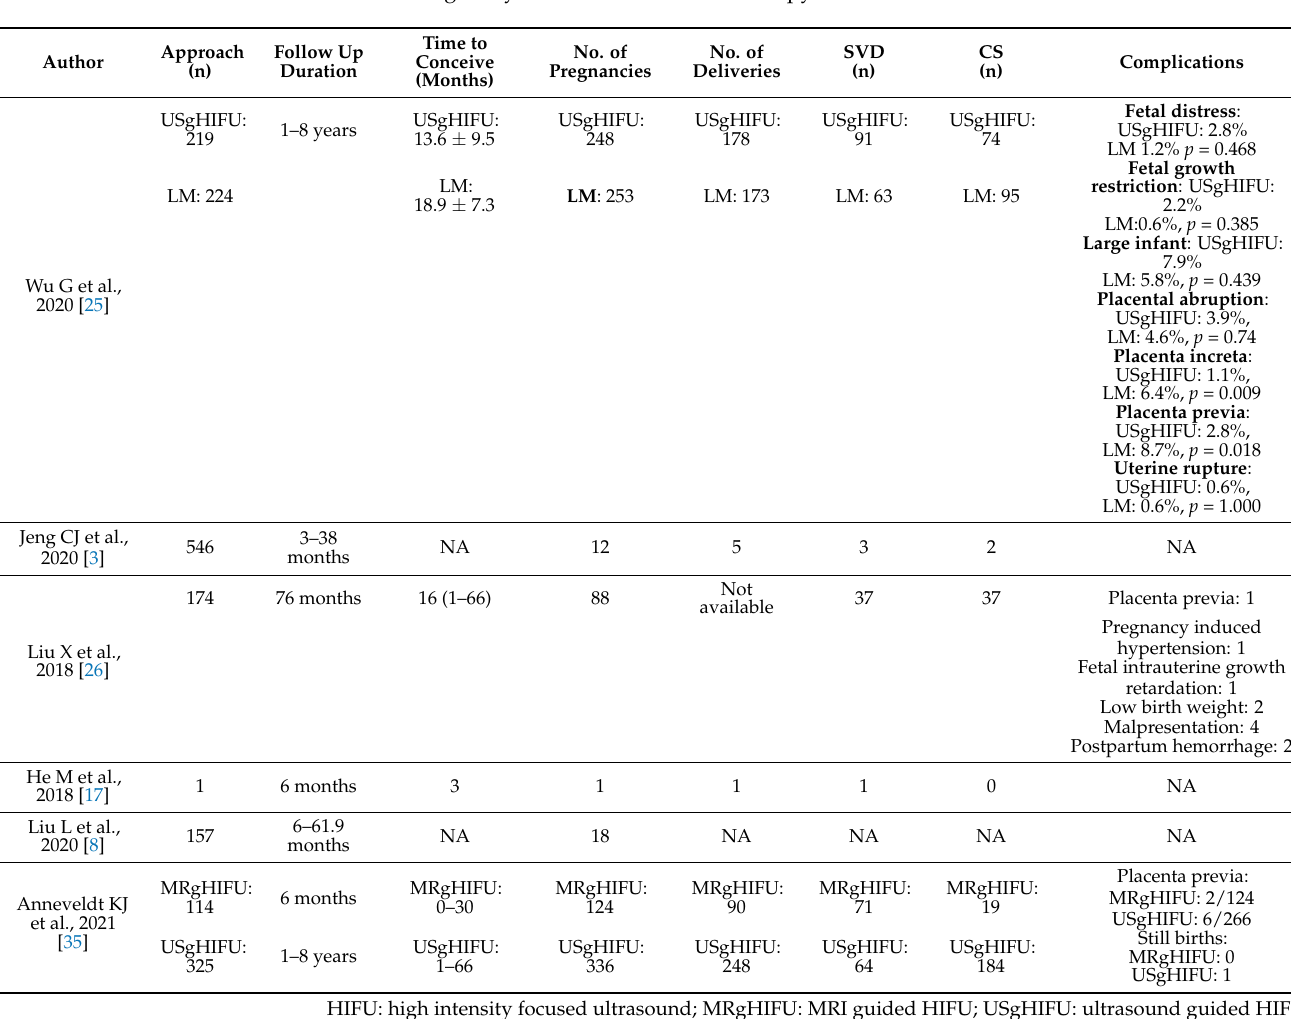
Table 8. Pregnancy outcomes after HIFU